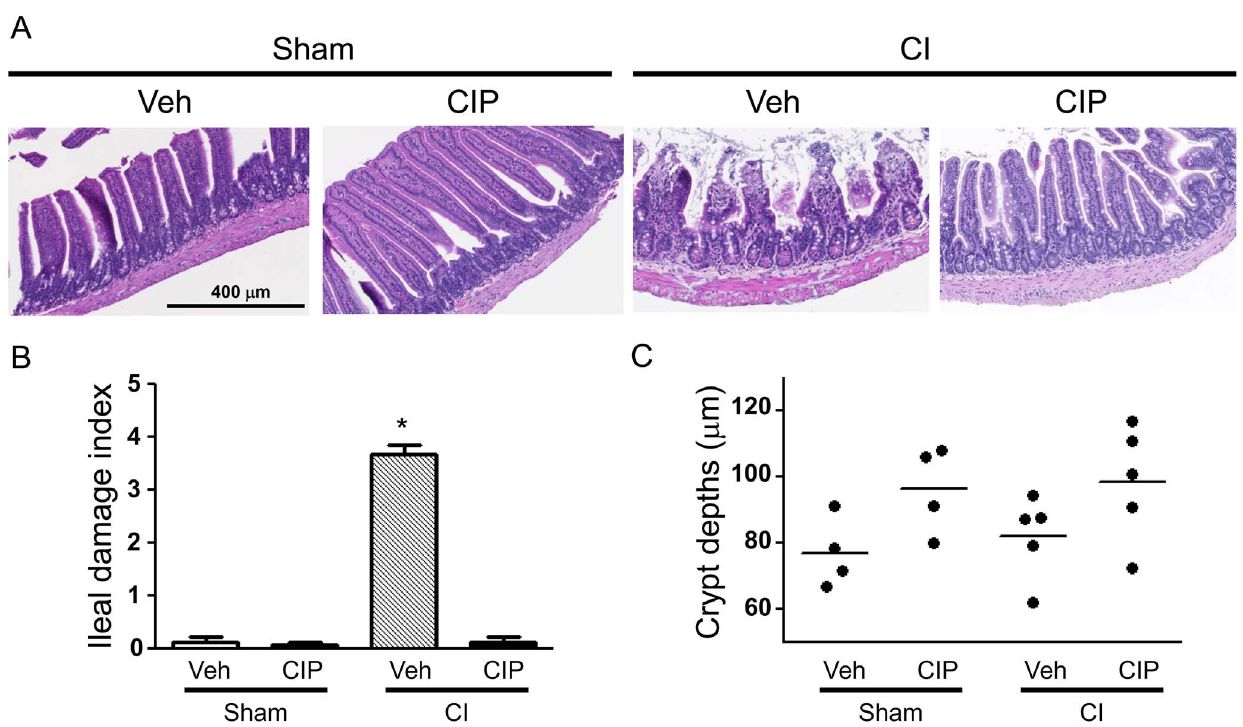
Figure 5. CIP inhibited ileum injury after CI. On day 10 after CI, ileal samples were collected from surviving mice and prepared for hematoxylin- eosin staining on paraffin sections. (A) Representative histopathology photos are shown, (B) An average mucosal injury grade was calculated as a damage index of 5 villa in 3 representative mice ( n =15) per group. * p , 0.05 vs. sham-Veh, sham-CIP, and CI + CIP, and (C) Crypt depth was measured. n =4 2 5 per group. CI: combined injury; CIP: ciprofloxacin; Veh: vehicle.